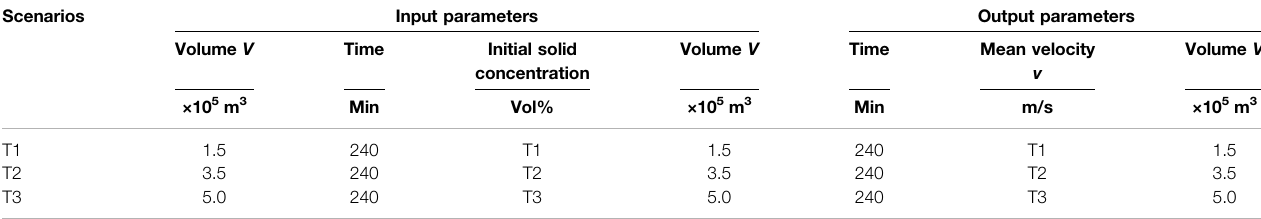
TABLE 8 | Input parameters used to simulate HCFs and DFs with Titan2F numerical code and output parameters for three different scenarios.